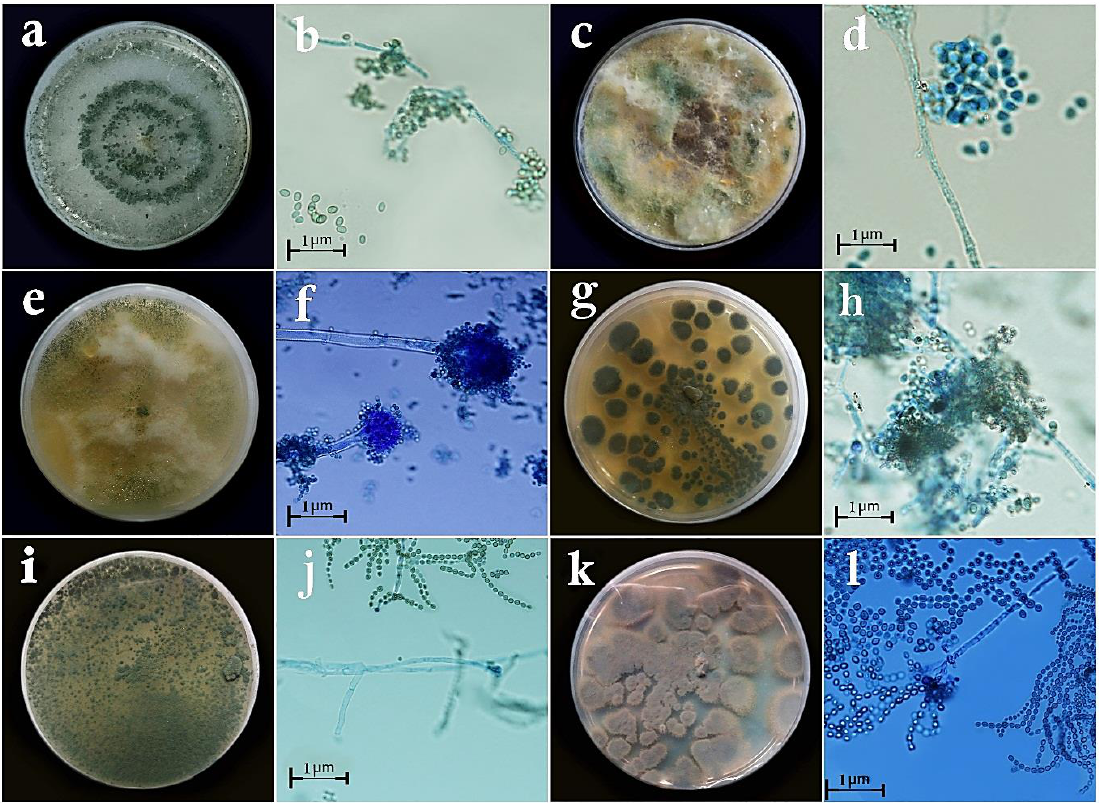
Figure 2. Antagonistic fungi used in the study: ( a ) colony of Trichoderma viride on PDA medium; ( b ) conidia and conidiophores of Trichoderma viride ; ( c ) colony of Trichoderma virens on PDA; ( d ) conidia and conidiophores of Trichoderma virens ; ( e ) colony of Aspergillus flavus on PDA; ( f ) conidia and conidiophores of Aspergillus flavus ; ( g ) colony of Penicillium rubens (MN395854.1) on PDA; ( h ) co- nidia and conidiophores of Penicillium rubens (MN395854.1); ( i ) colony of Penicillium rubens (MN395851.1) on PDA; ( j ) conidia and conidiophores of Penicillium rubens (MN395851.1); ( k ) colony of Penicillium decaturense on PDA; ( l ) conidia and conidiophores of Penicillium decaturense .